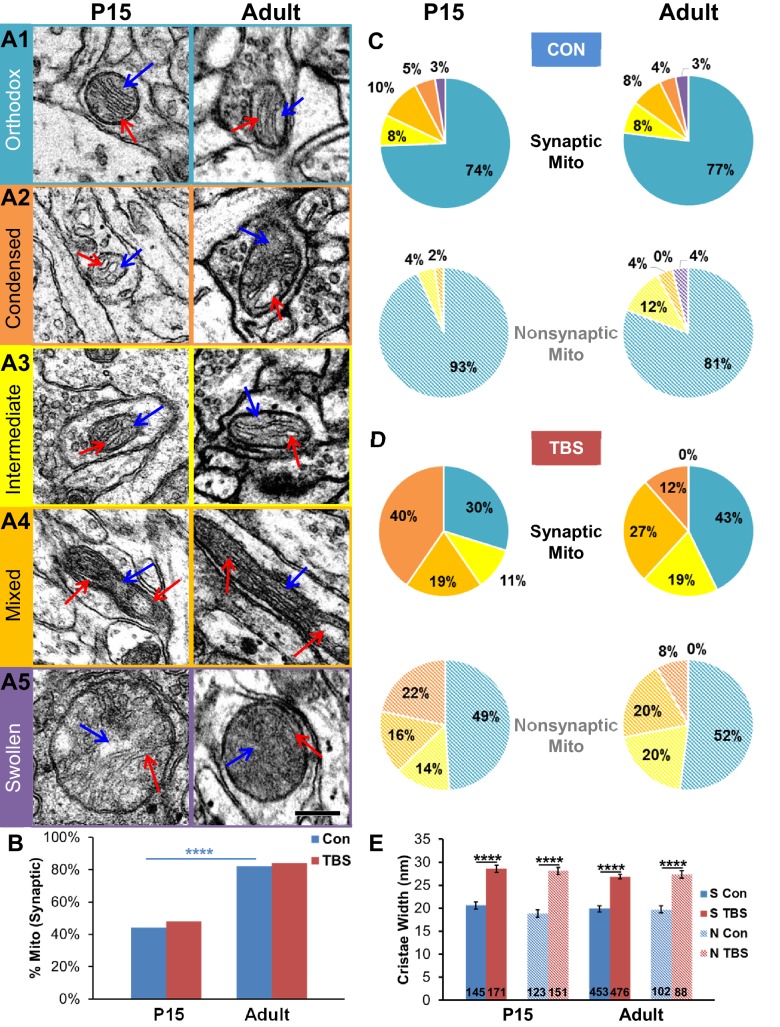
Synaptic and nonsynaptic mitochondria exhibited non-orthodox configurations after TBS-induction of LTP at both ages.(A1) The orthodox mitochondrial configuration had cristae with uniformly thin widths (<20 nm) and homogeneously gray matrices. (A2) The condensed mitochondrial configuration had wider and more variable cristae (>30 nm, red arrows) and less uniform matrices. (A3) Mitochondria with an intermediate configuration had cristae ranging in width from 20 to 30 nm and nonuniform matrices. (A4) Long mitochondria often had a mixed appearance showing distinct regions of orthodox, condensed, or intermediate configurations along their lengths. (A5) Swollen mitochondria were more than two times wider than other mitochondria. (Cristae are labeled with red arrows and the matrix is labeled with blue arrows in the micrographs of A1-5. Scale bar in A5 is 0.25 µm for A1-5.) (B) Under control conditions, 44% of P15 mitochondria and 82% of adult mitochondria were synaptic and located among the presynaptic vesicles (X2 = 37.5, df = 1, p<0.0001). These proportions did not differ significantly between TBS and control conditions at either age. (C) Comparison of mitochondrial configurations showed no significant differences between synaptic and nonsynaptic mitochondria or between P15 and adult ages under control conditions, or in the (D) TBS condition. Significant differences between Con and TBS are discussed in the text. (Pie chart colors in C and D match colors of the mitochondrial configuration boxes in A, with solid shades for synaptic and hatched shades for nonsynaptic mitochondria.) (E) At both ages, the cristae were wider in the TBS condition for both synaptic and nonsynaptic mitochondria.